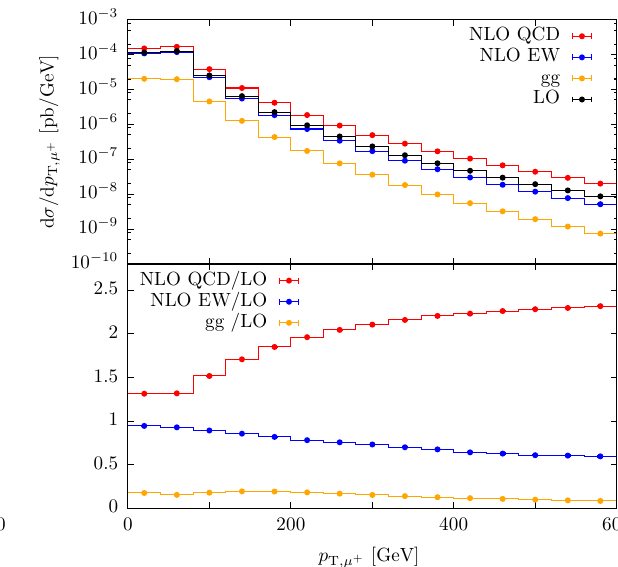
cientin R NLO )inparticularforthe R NLO ratio. 11 Eventhough lin quad R LO and R NLO show the same qualitative behaviour for lin lin ( quad ) WW and WZ production, from a quantitative point of view 11 For similar results see Ref.